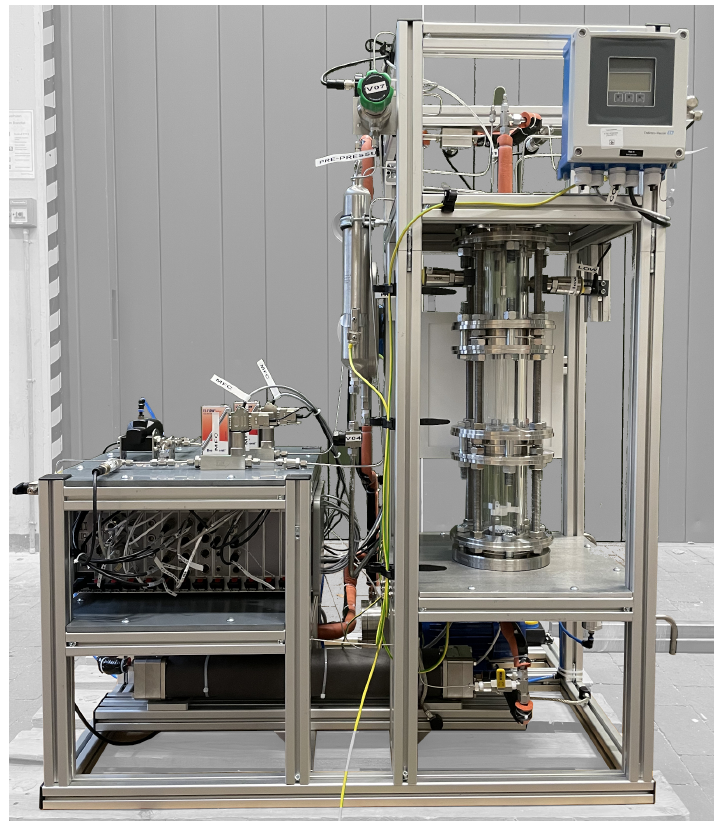
Figure 10. Completely assembled and equipped setup for experiments with the original material system on site of the project